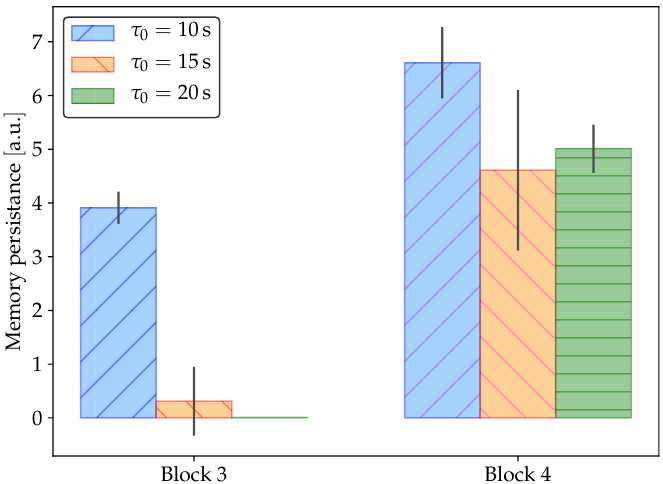
Figure 11. Memory persistence in Pavlovian conditioning. Results correspond to 10 experiments in the same conditions as in Figure 10. As the characteristic response time of the memristor, τ 0 , increases, it takes longer to produce a strong association between the conditioned stimulus (bell) and the conditioned response